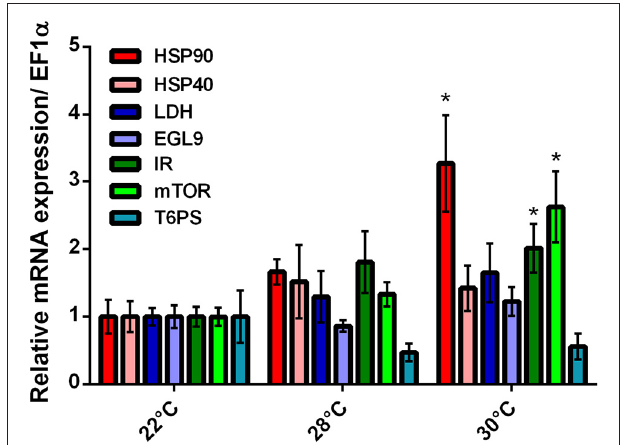
FIGURE 2 | Relative mRNA expression of N. triangulifer larvae subjected to chronic thermal stress treatment . Genes selected for this study include thermally responsive genes HEAT SHOCK PROTEIN (HSP) 90, 40, an oxygen sensing gene EGG LAYING DEFECTIVE 9 ( EGL-9 ), LACTATE DEHYDROGENASE ( LDH ), and energetically associated genes INSULIN RECEPTOR ( IR ), mechanistic TARGET OF RAPAMYCIN ( mTOR ), and TREHALOSE 6 PHOSPHATE SYNTHASE ( T6PS ). All data are normalized to control (22 ◦ C) ELONGATION FACTOR 1 α ( EF1 α ). Error bars represent standard deviations from the mean ( N = 7 for 22 and 28 ◦ C, N = 5 for 30 ◦ C). Wilcoxon rank sum test was performed and *Indicates significant difference compared to control (22 ◦